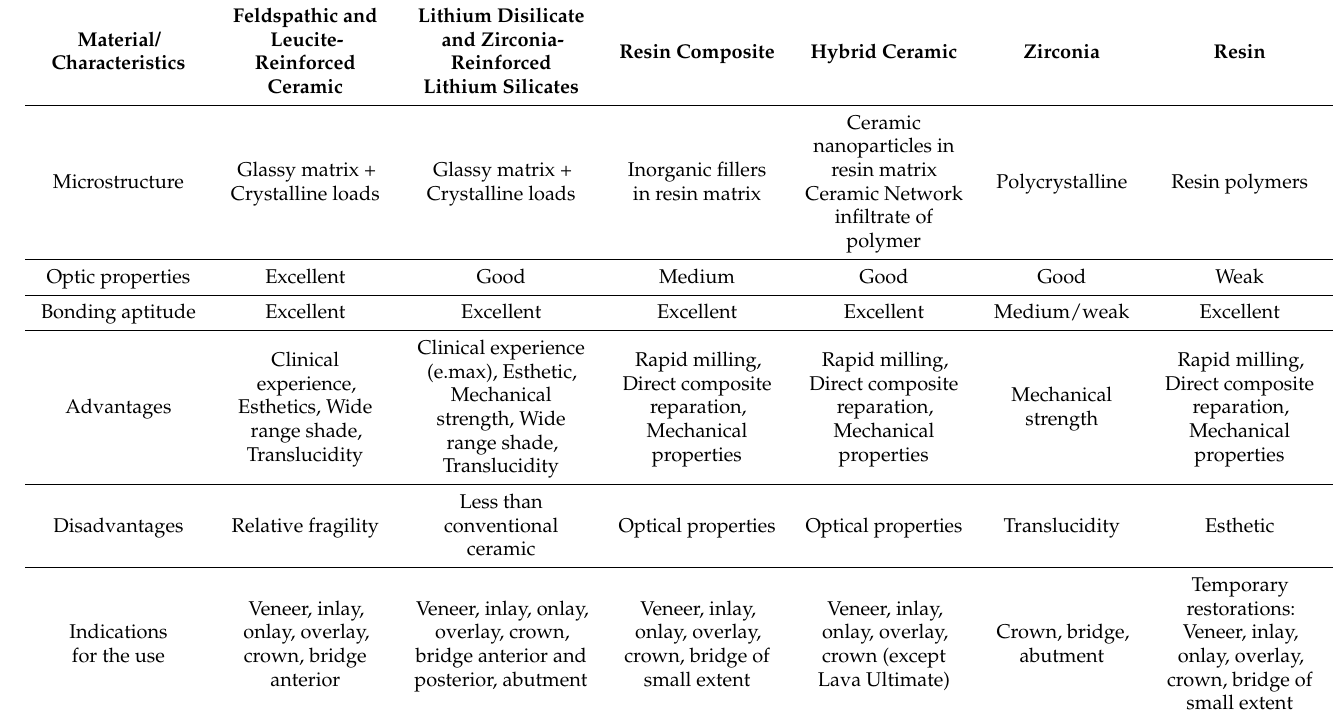
Table 2. Features and indications for the use of the chairside CAD/CAM